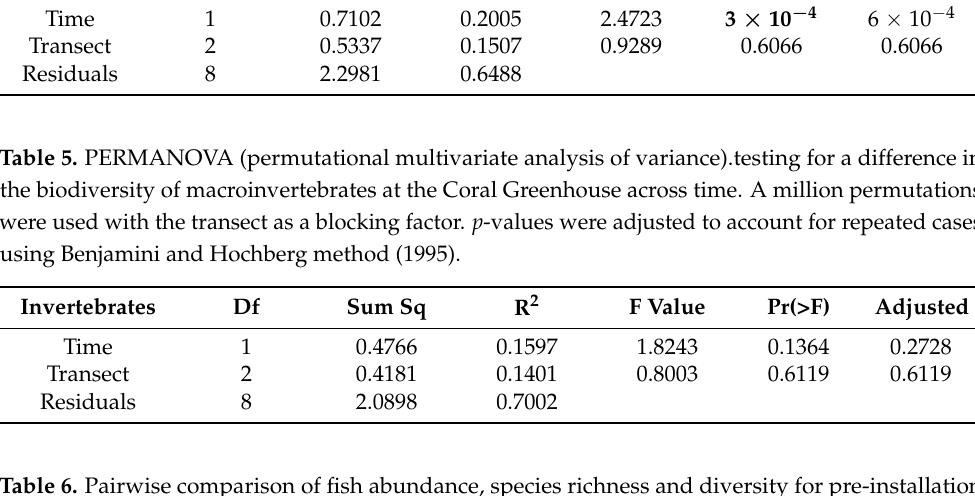
Table 6. Pairwise comparison of fish abundance, species richness and diversity for pre-installation (2018) and post-installation (2020–22). Significant values in bold